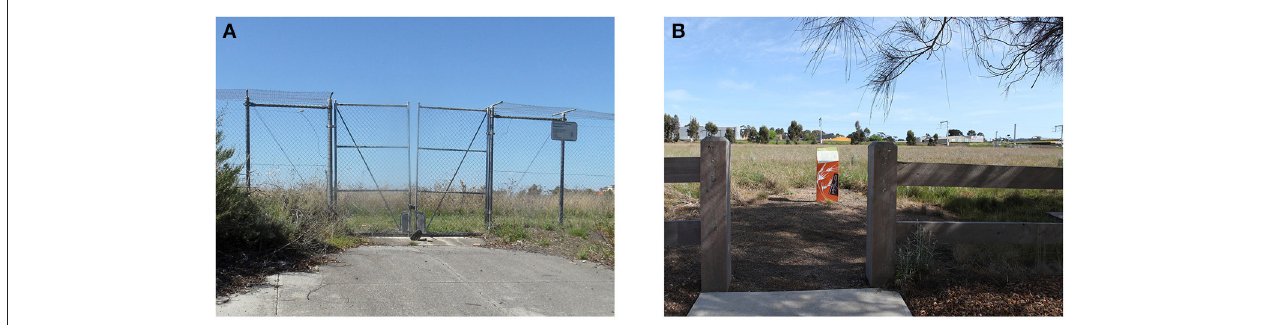
FIGURE 1 | (A) An example of poor biophilic design: Exclusionary fencing, poor maintenance, and minimal interpretive signage only make the residents who live opposite this grassland resentful. Photo: Adrian Marshall CC 4.0. (B) Engaging biophilic design: Good quality fencing invites visitors into the grassland experience. Well-positioned and designed signage welcomes visitors. Care is shown. Photo: Adrian Marshall CC 4.0. eschewing of disciplinarity means problems can be seen in a new light, and a common goal